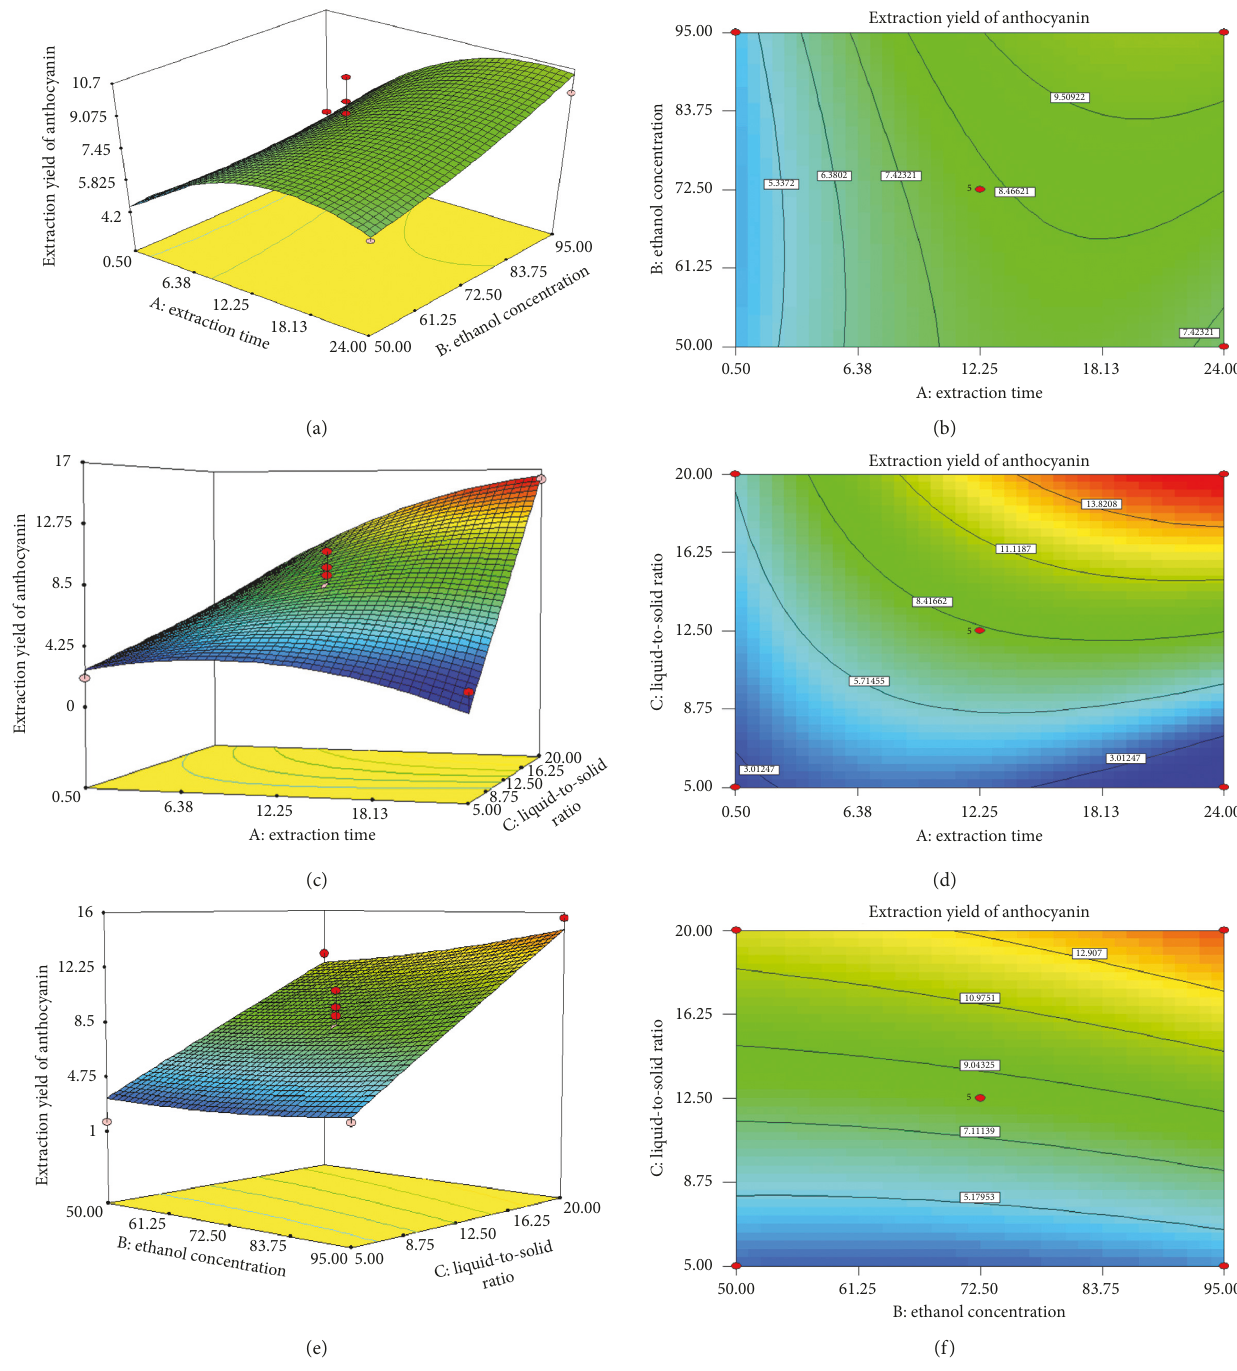
Figure 2: Response surface analysis of blueberry anthocyanin extraction. The effect of extraction time and ethanol concentration on extraction anthocyanin yield: (a) response surface plot and (b) contour plot. The effect of extraction time and liquid-to-solid ratio on the anthocyanin extraction yield: (c) response surface plot and (d) contour plot. The effect of ethanol concentration and liquid-to-solid ratio on extraction anthocyanin yield: (e) response surface plot and (f) contour